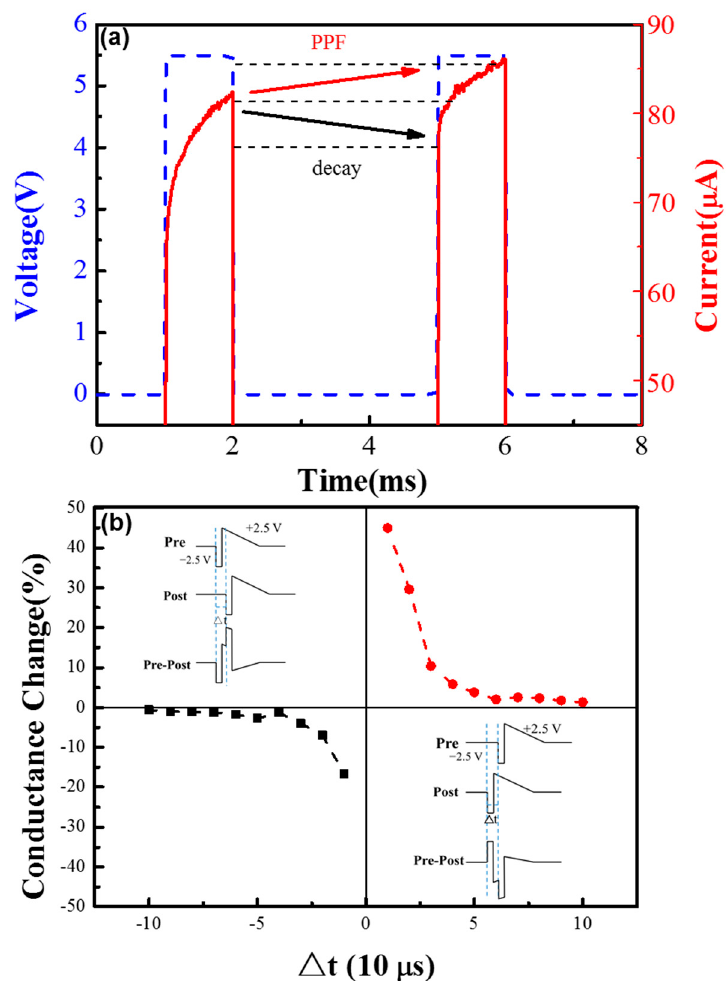
Figure 5. ( a ) The short-term plasticity: paired-pulse facilitation (PPF) synaptic function of the Ta/TaO x /Al 2 O 3 /Pd device; ( b ) illustration of spike signals and spiking-time-dependent plasticity (STDP) function of the device. The individual pre-synaptic or post-synaptic spike signal is designed as a pair of pulses ( − 2.5 V, 10 μ s pulse and 2.5 V triangle pulse) applied to the top and bottom electrode, respectively.